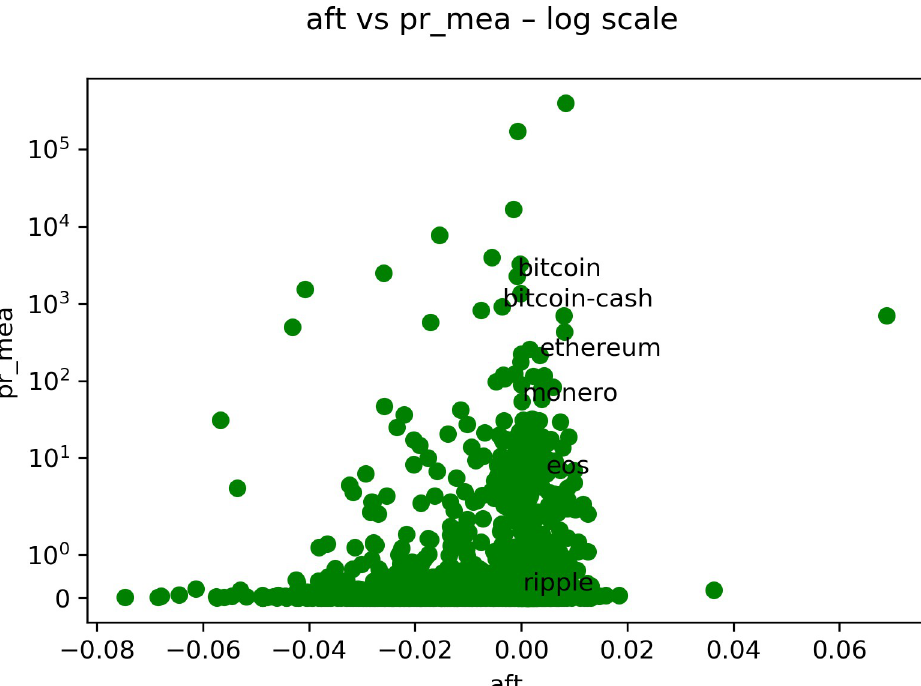
Fig 2. A typical example of the different types of studies that we analyze. We compare the antifragility values (in the x- axis) of every cryptocurrency in a weekly scale (according to the green color), with its mean price, indicated by pr_mea, (in the y- axis). Note that in this case the symlog scale is just a log scale because there are no negative values in the y-